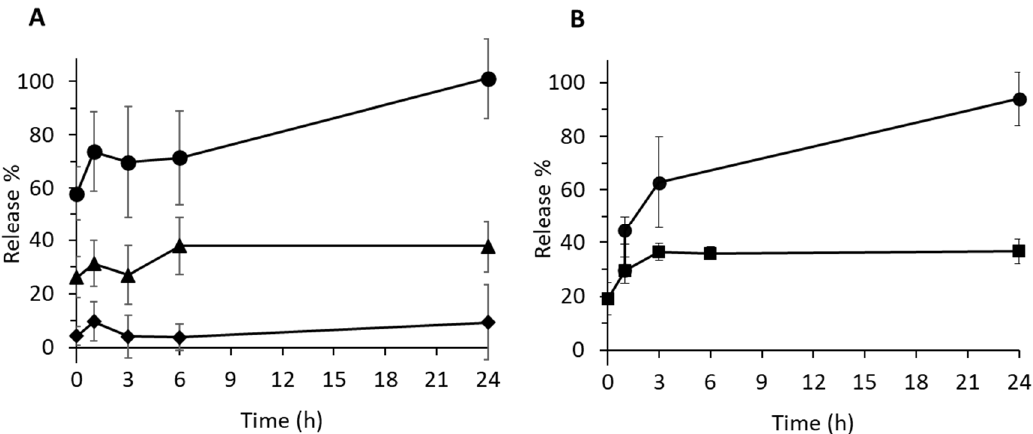
Figure 11. ( A) pH-dependent VCM release profiles of PLGA 15 C NPs in 100 mM PB at pH = 5.3 (circle), pH = 6.3 (triangle), and pH = 7.4 (diamond). ( B ) VCM release profile of PLGA 15 C NPs in RPMI cell culture medium containing 10% serum (square) at pH 7.4. In another set of experiments, the pH was changed from 7.4 to 5 (circle). All experiments were performed in triplicate at 37 °C.